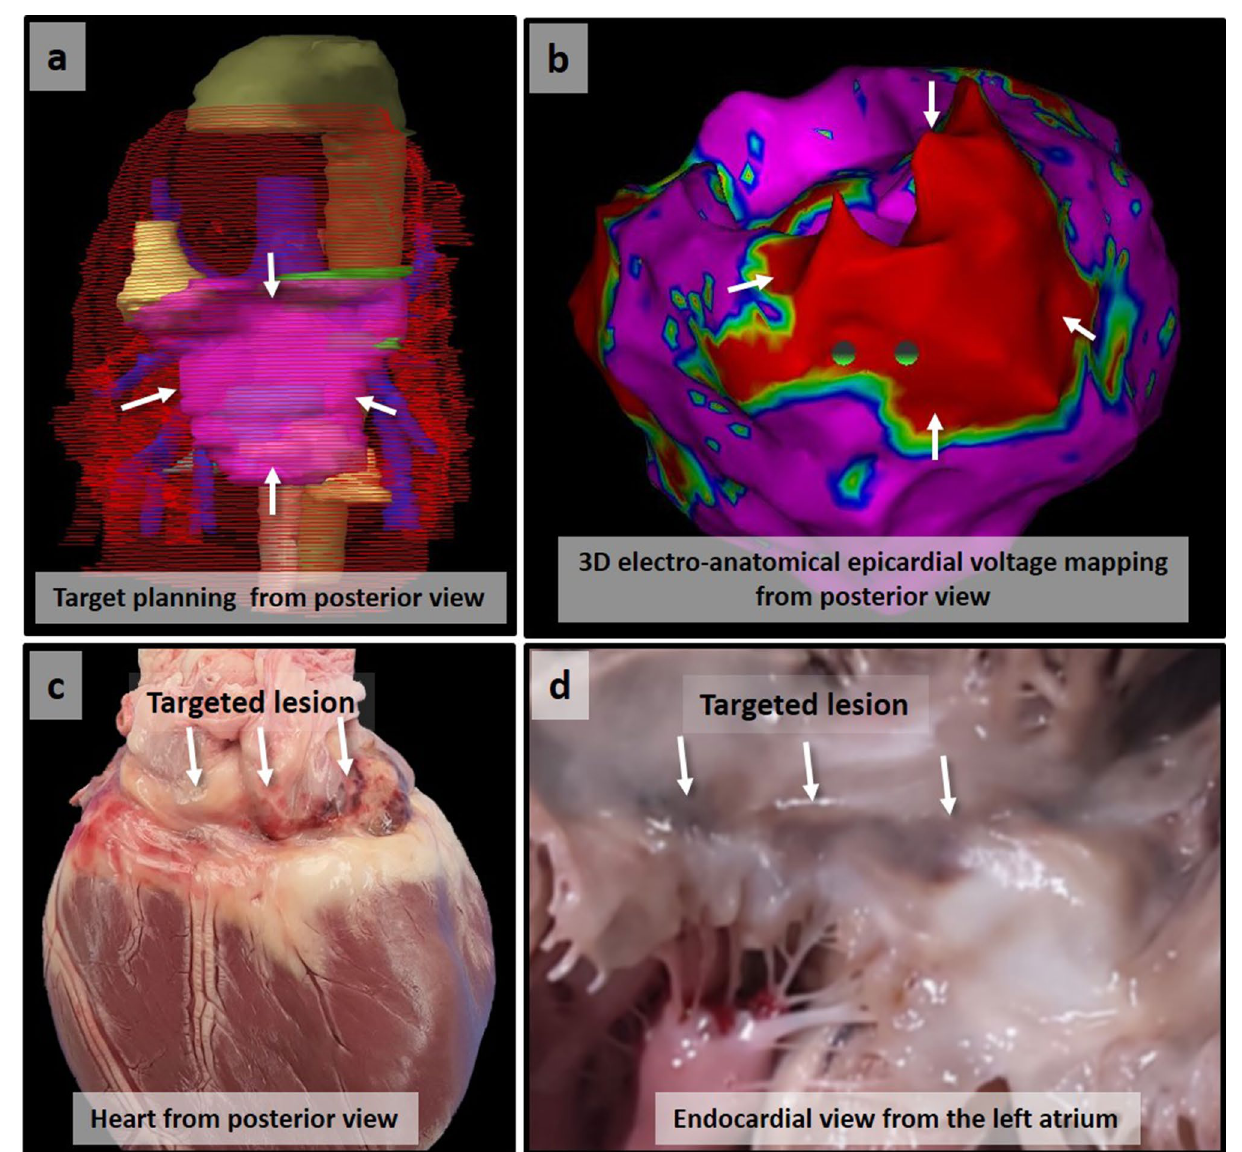
Figure 3. Myocardial necrotic scar formation on irradiated left atrial posterior wall. The reconstructed target area from the posterior view (white arrows in a ) corresponds with the low voltage area (red area with white arrows in b ) indicating a scarred lesion on voltage mapping with the CARTO-3 electroanatomical mapping system (Biosense Webster Inc.). The targeted lesion is grossly distinguishable at 4 months from both the epicardial ( c ) and endocardial ( d )